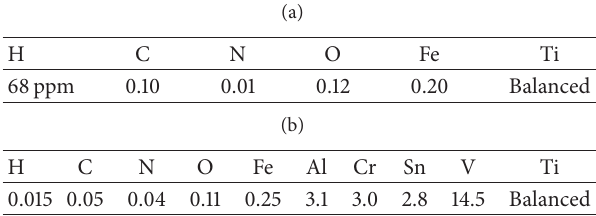
Table 1: (a) Analyzed composition of the as-received CP-Ti sheet (wt.%). (b) Analyzed composition of the as-received Ti-153 sheet (wt.%).